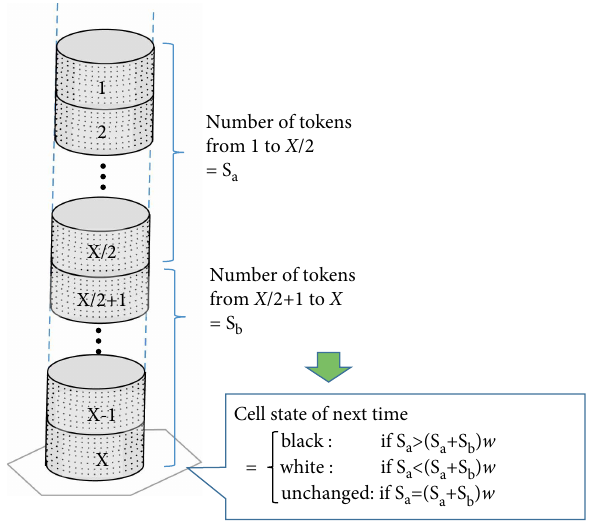
Figure 5: Schematic of the cell state change. At the end of the movement and modification of the tokens, the subsequent state of each cell is determined by the ratio of the numbers of tokens. The subsequent cell state (black or white) is determined using the ratio of the number of tokens labeled 푋/2 or smaller to the total number of tokens and assigning it to formula